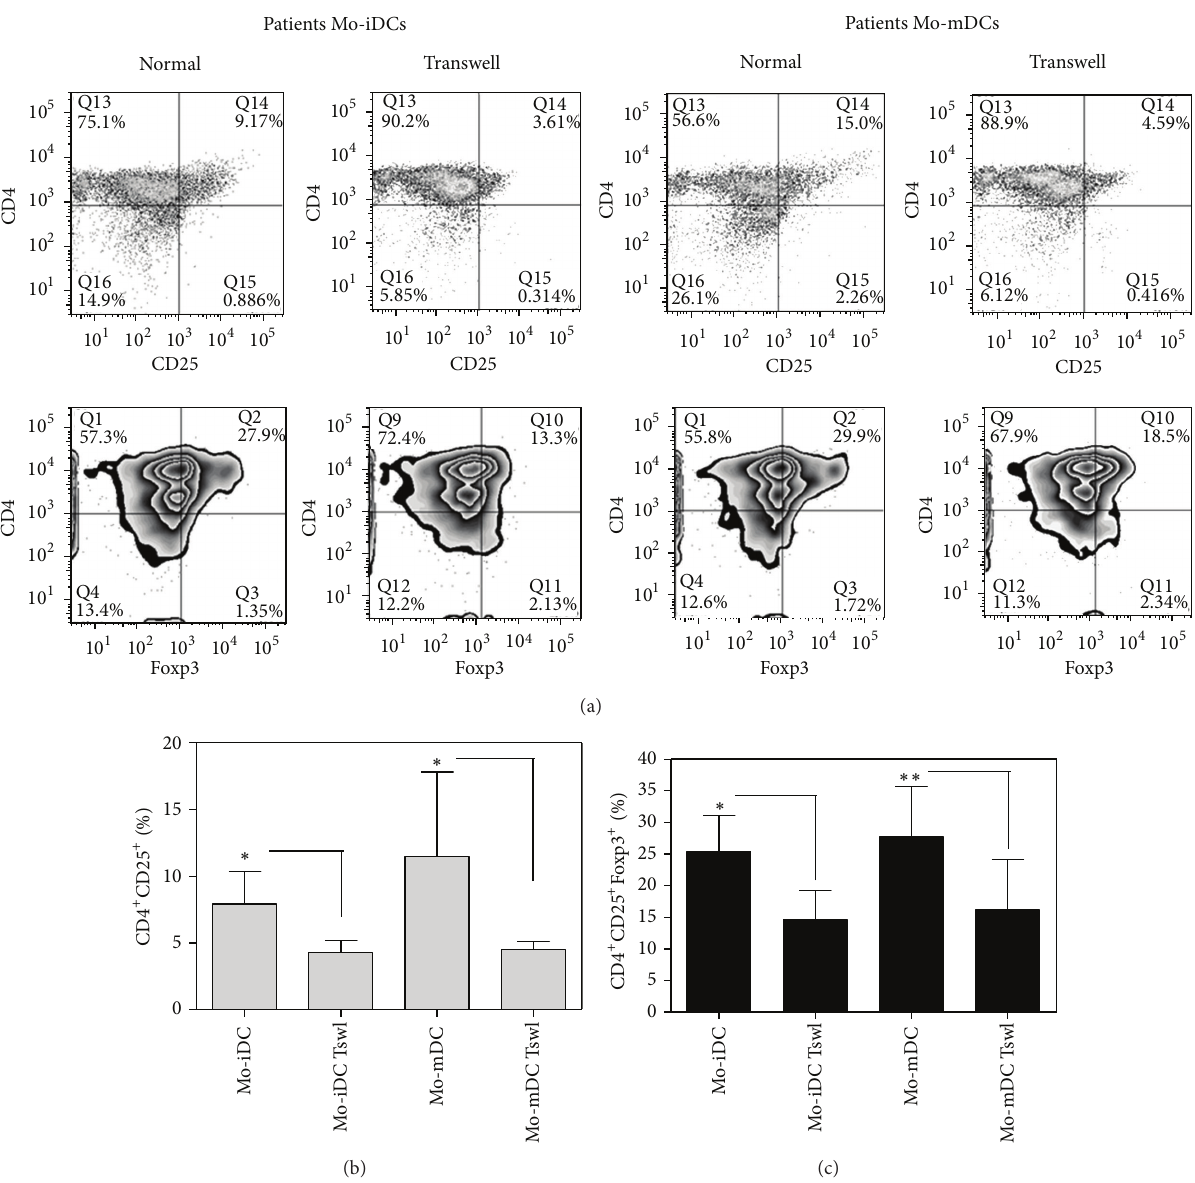
Figure 3: Patients’ Mo-DCs induce expansion of regulatory T lymphocytes with the cooperation of contact molecules. Mo-DCs from breast cancer patients were cocultured with allogeneic CD 4 + CD45RA + cells for five days in a transwell system or not. At the end of culture the phenotype of lymphocytes was evaluated by flow cytometry. (a) Representative experiments of CD25 and Foxp3 expression in CD 4 + lymphocytes stimulated by immature DCs (Mo-iDCs) or mature DCs (Mo-mDCs) from breast cancer patients in normal or transwell condition. Average frequency of CD2 5 + cells (b) and CD 4 + CD2 5 + Foxp 3 + cells (c) after CD 4 + CD45RA + lymphocytes’ coculture with patients’ Mo-DCs ( ∗ 𝑃 < 0.05 ; ∗∗ 𝑃 < 0.01 , paired t- test; 𝑛 = 4 ). (Tswl: transwell system; mature Mo-DCs were activated by TNF-alfa for 48